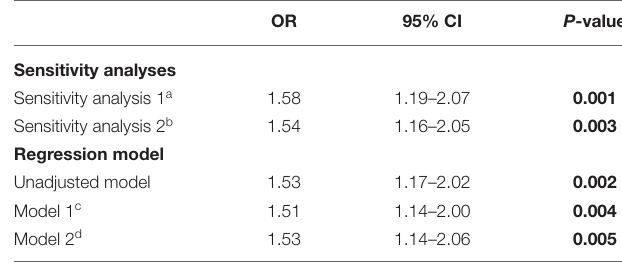
TABLE 4 | Sensitivity analyses and multiple logistic regression analysis of the association between psoriasis and the later development of BP (case-control study